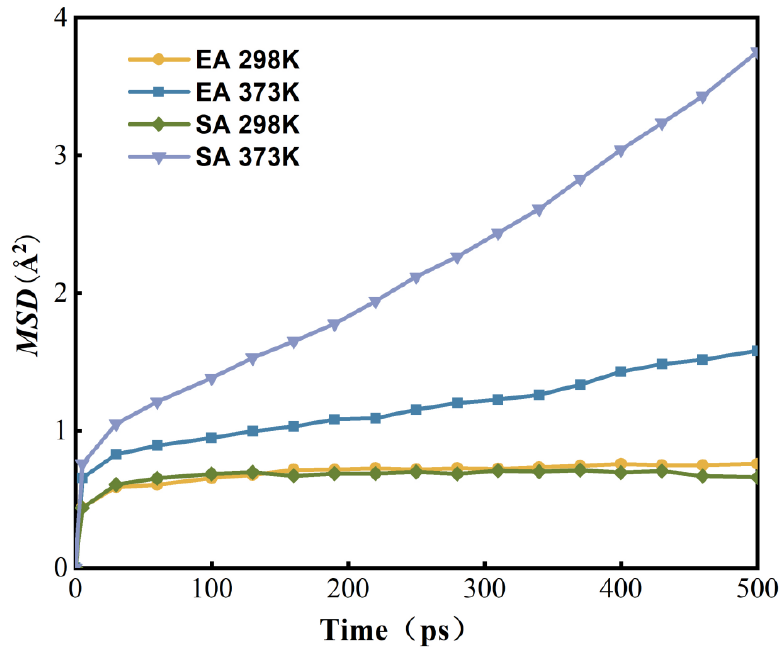
Figure 5. MSD curves of SA and EA in NR